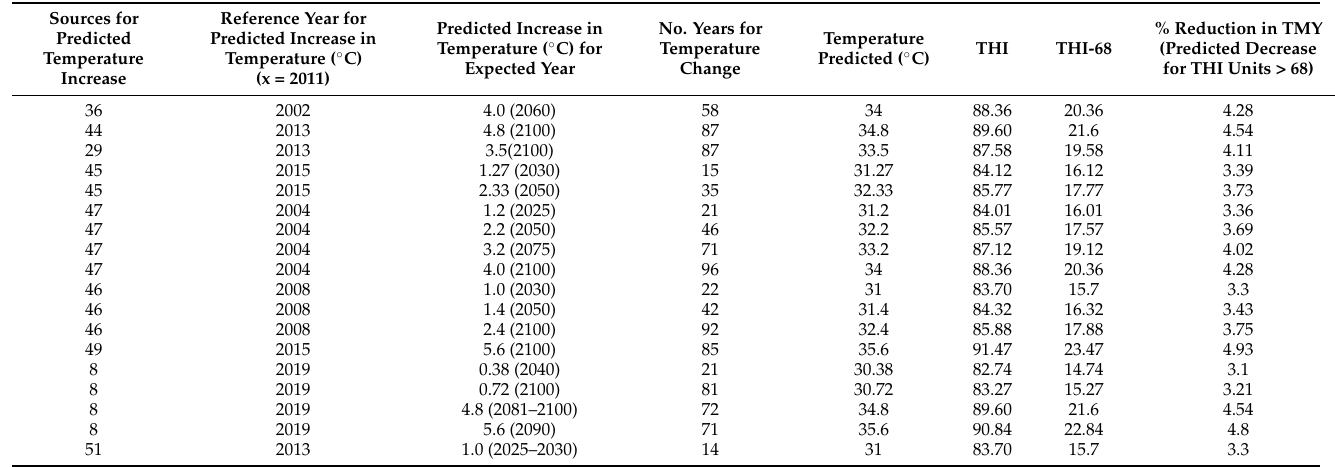
Table 3. Review of predictions of increased temperature in Egypt, temperature–humidity index (THI), and reduction in total milk yield (TMY) per cow and available milk yield per person. Sources for Predicted Temperature